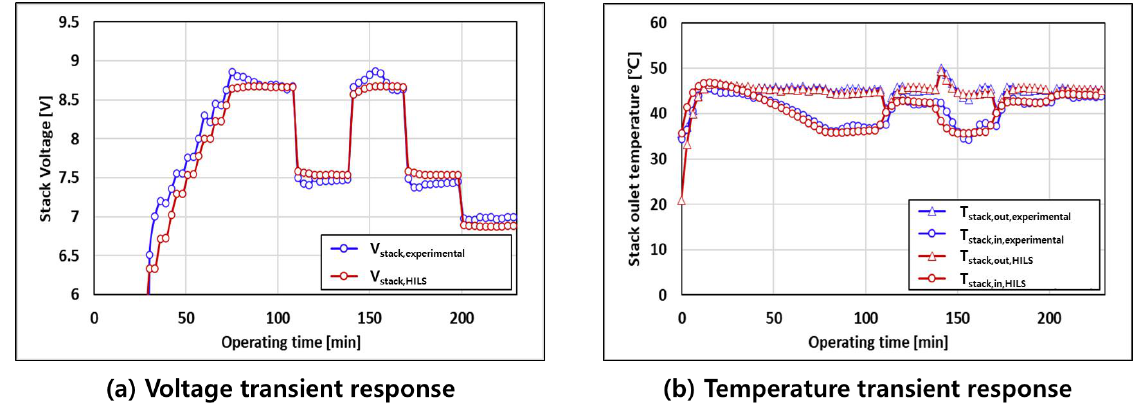
Figure 10. Comparison of transient responses between the HILS system and experimental setup.